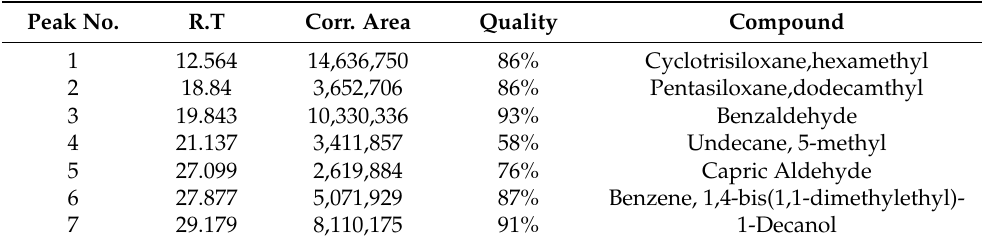
Table 2. Volatile organic compounds (VOCs) detected from Rice ( Oryza sativa ). Peak No.